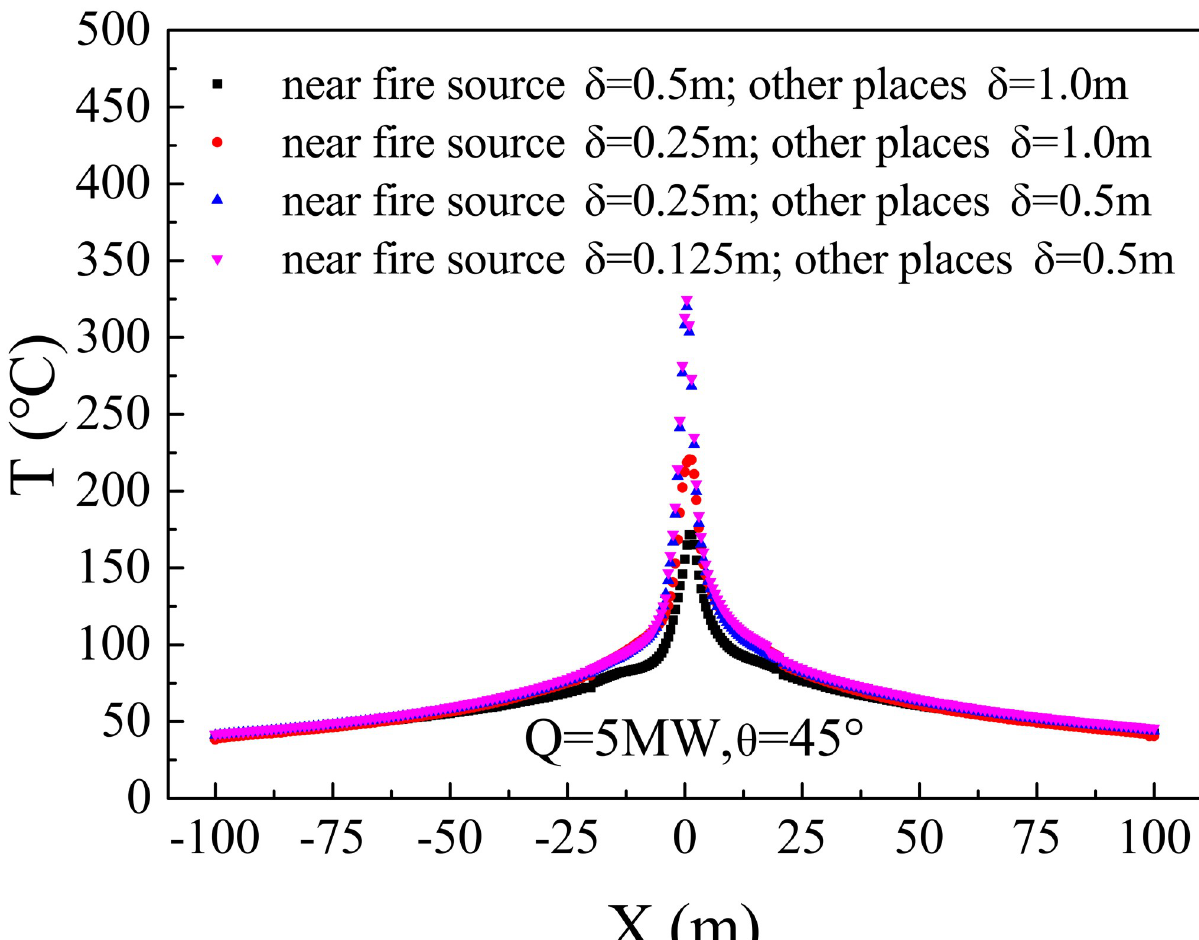
Fig 2. Grid size sensitivity